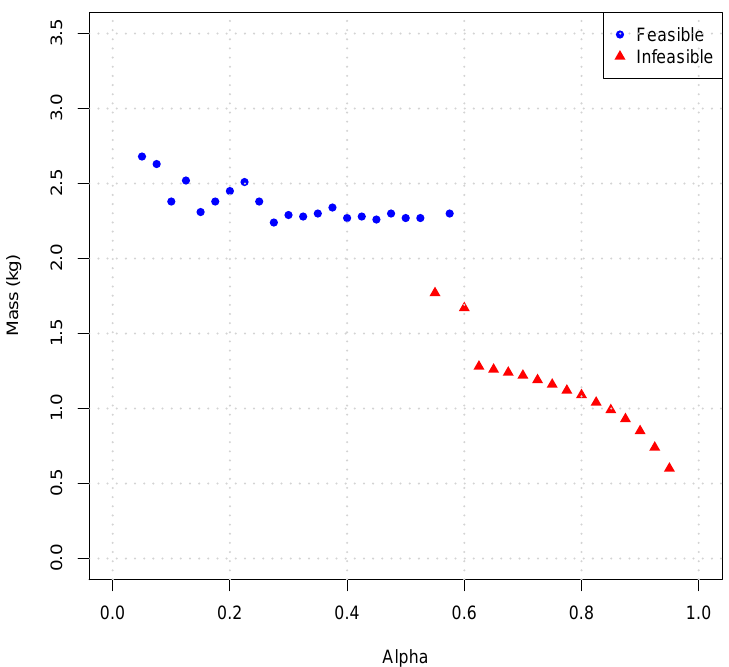
Figure 19. First DOE: optimum mass for different α values calculated by the